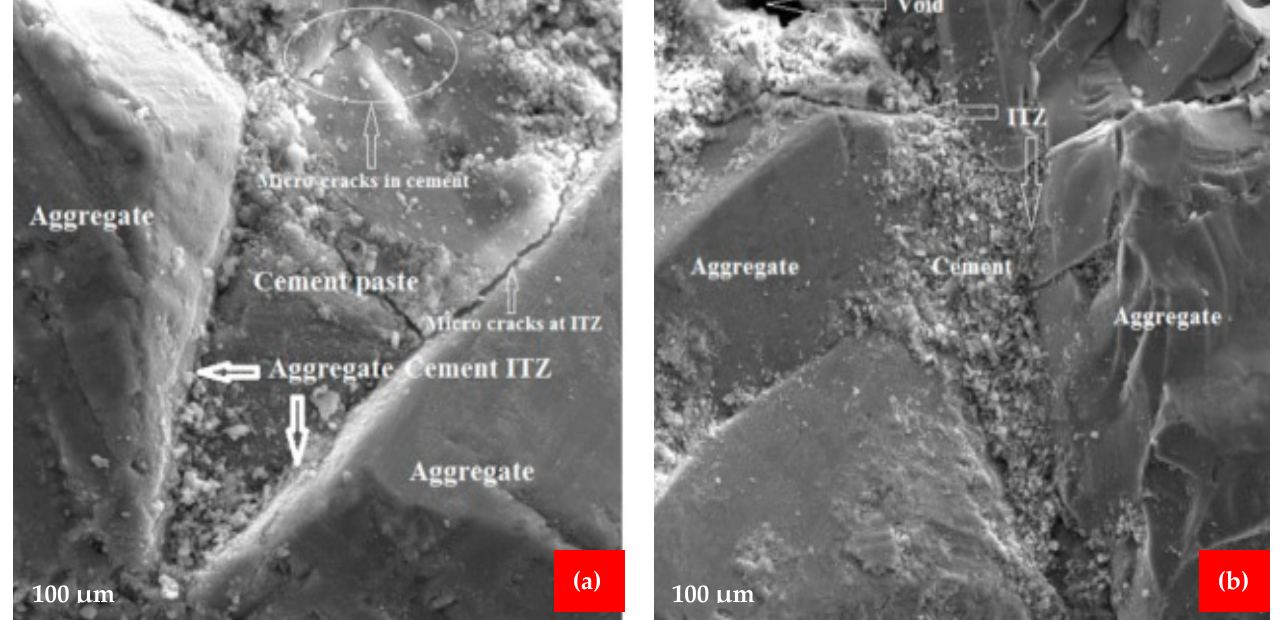
Figure 18. ( a ) Cracks in paste and aggregates, ( b ) aggregates paste ITZ [50].